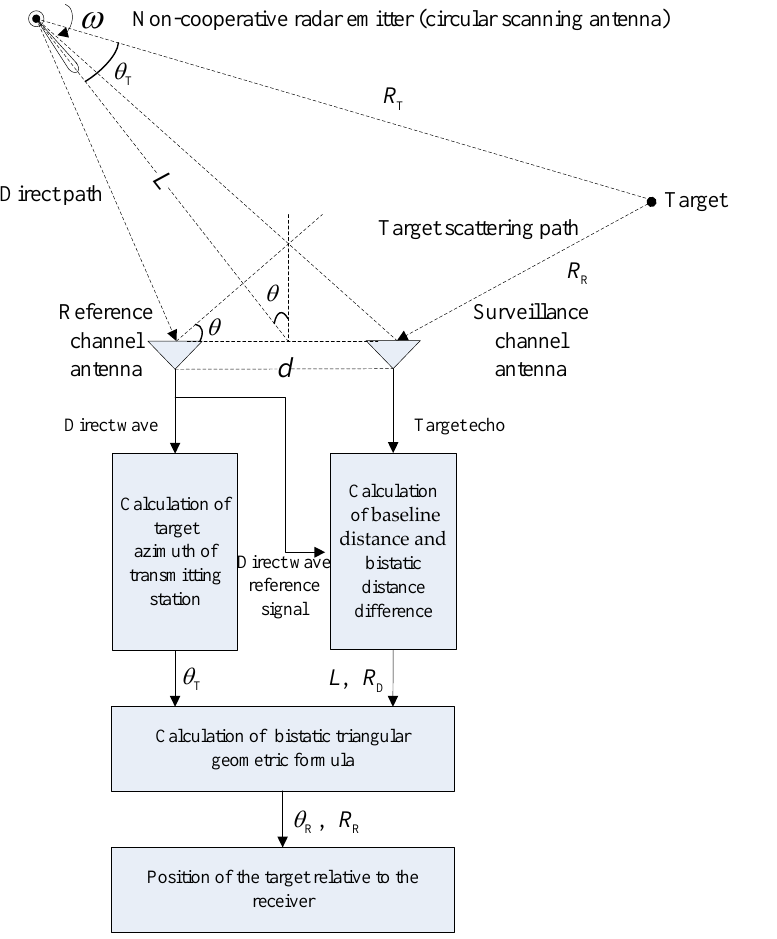
Figure 4. Target location method of HBR system.